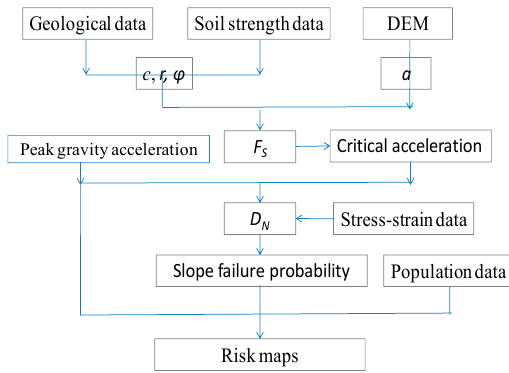
Figure 2. Flow chart showing the steps involved in producing a seismic risk map ( c is the cohesive strength, φ is the internal friction angle, r is the material unit weigh, a is the slope angle, F s is the static factor of safety, and D N is the landslide movement distance in cm. DEM is Digital Elevation Model ).